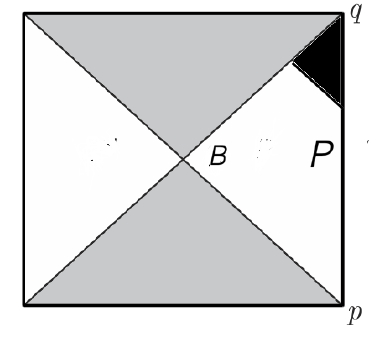
Figure 2 . In this diagram, the “exterior” region for a given cut of the future horizon is the region to the right of, and spacelike separated from, the given cut. In the case of a cut along the surface B — the intersection of the past and future horizons of the static patch P — the exterior region is simply P . What is exterior to a later cut of the future horizon is a smaller spacetime region, such as the example shaded in